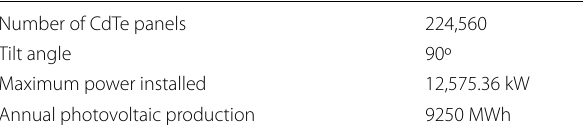
Table 6 Data for cadmium telluride photovoltaic system sizing for Terceira